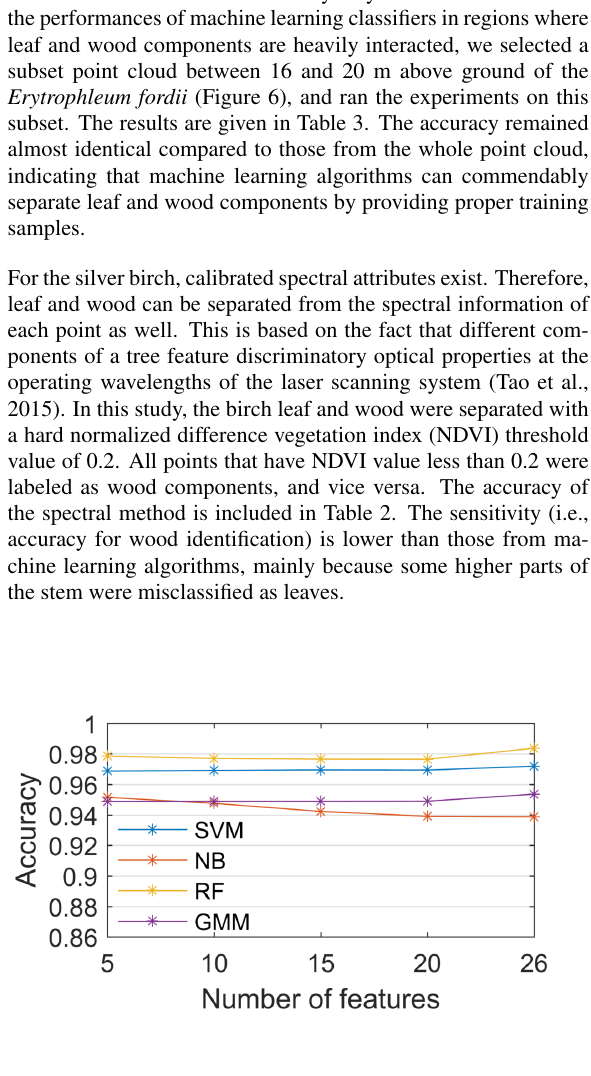
Figure 4. Performance of four classifiers for the Erytrophleum fordii as a function of the different feature sets. Feature sets were determined based on the Fisher filter method described in section 3.2.